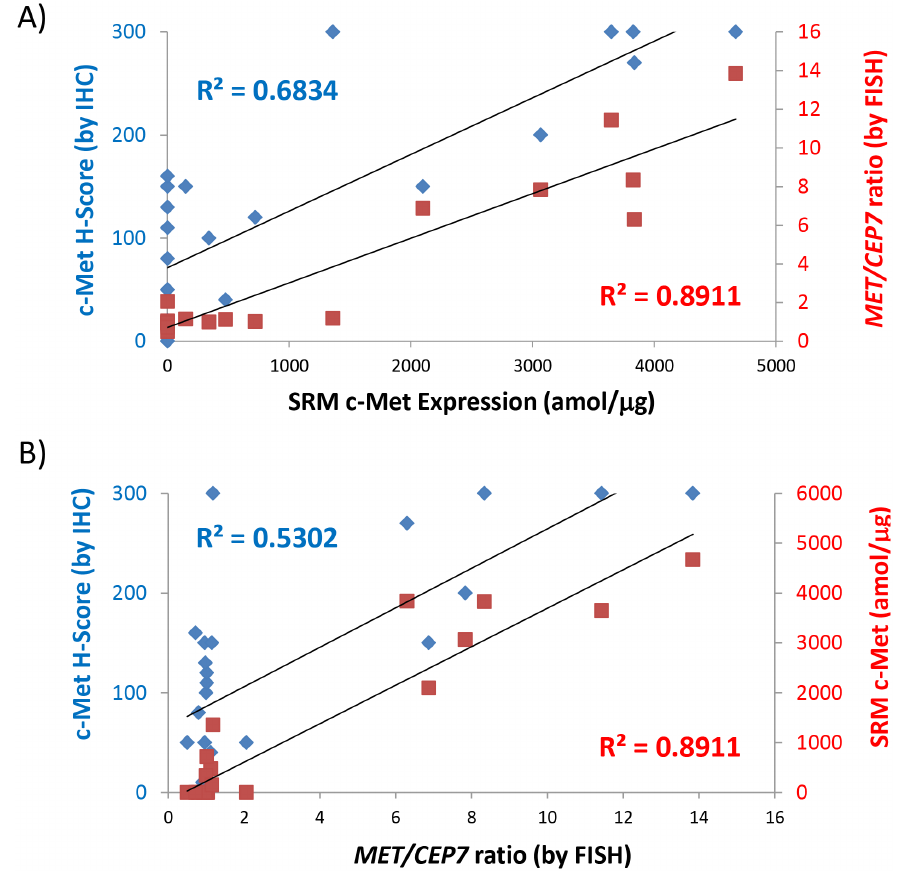
Figure 9. Three-way SRM-IHC-FISH assay correlations. (A) Correlation of SRM Met level (amol/ m g, x-axis) to Met H-Score by IHC (blue, left y- axis) and to FISH MET/CEP7 ratio (red, right y-axis) in GEC FFPE tissues having all three tests performed. Correlation coefficients for the comparisons are in their respective colors. (B) Correlation of FISH MET/CEP7 ratio (x-axis) to Met H-Score by IHC (blue, left y-axis) and to SRM Met level (red, right y- axis) in GEC FFPE tissues having all three tests performed. Correlation coefficients for the comparisons are in their respective colors.